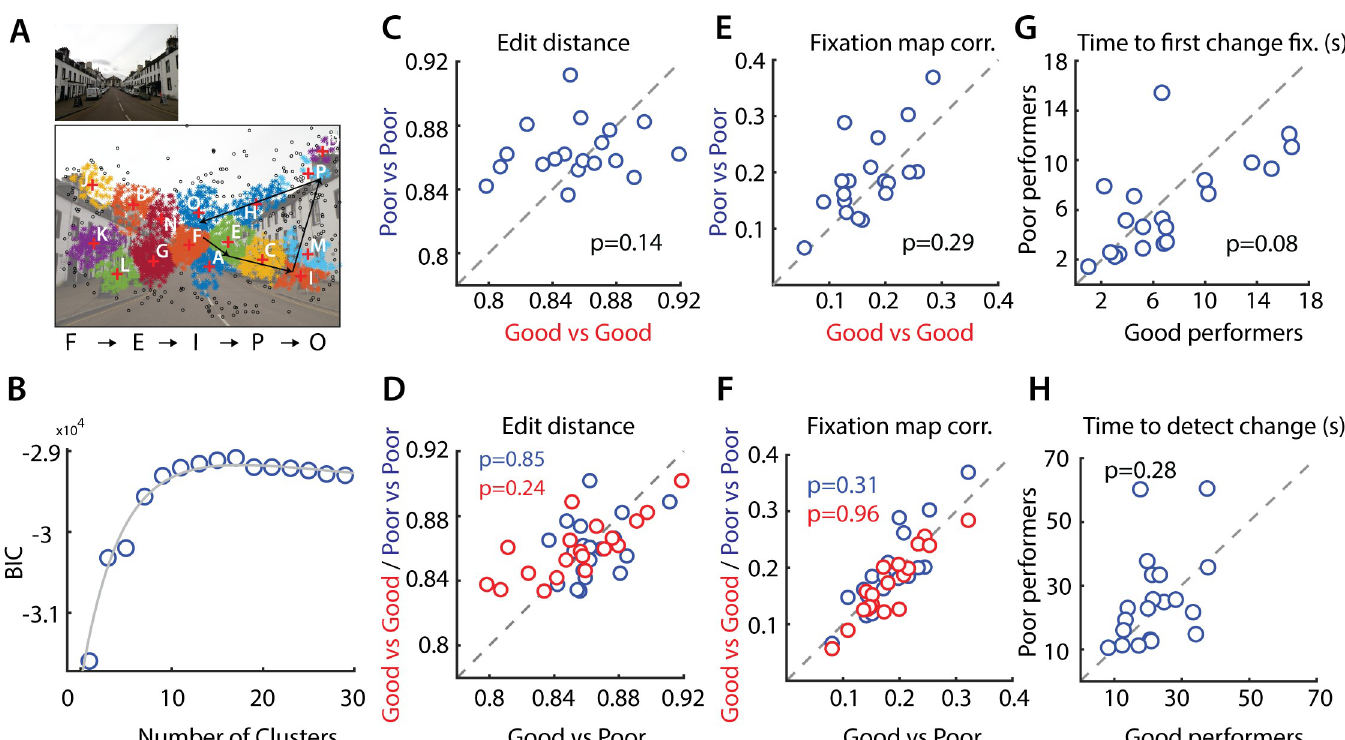
Fig 2. Scan paths and fixation maps do not distinguish good from poor performers. A. (Left) Representative image used in the change blindness experiment (Image #6 in Data Availability link). (Right) Clustering of the fixation points based on the peak of the fitted BIC (n = 13) profile. Fixation points in different clusters are plotted in different colors. Black fixations occurred in fixation sparse regions that were not included in the clustering. Black arrows show a representative scan path–a sequence of fixation points. The character “string” representation of this scan path is denoted on the right side of the image. B. Variation in the Bayesian Information Criterion (BIC; y-axis) with clustering fixation points into different numbers of clusters (x-axis; Materials and Methods). Circles: Data points. Gray curve: Bi-exponential fit. C. Distribution of edit distances among good performers (x-axis) versus edit distances among poor performers (y-axis). Each data point denotes median edit distance for each image tested (n = 19). Other conventions are the same as in Fig 1E. D. Distribution of intra-category edit distance (y-axis), among the good or among the poor performers, versus the inter-category edit distance (x-axis), across good and poor performers. Red and blue data: intra-category edit distance for good and poor performers respectively. Each data point denotes the median for each image tested (n = 19). Other conventions are the same as in panel C. E. Same as panel C, but comparing Pearson correlations of fixation maps among good (x-axis) and poor performers (y-axis). Other conventions are the same as in panel C. F. Same as in panel D, but comparing intra- versus inter-category Pearson correlations of fixation maps. Other conventions are the same as in panel D. G. Distribution of time to first fixation within the region of change (in seconds) for good performers (x-axis) versus poor performers (y-axis). Other conventions are the same as in panel C. H. Same as in E, but comparing time to detect change (in seconds) for good versus poor performers. Other conventions are the same as in panel G.